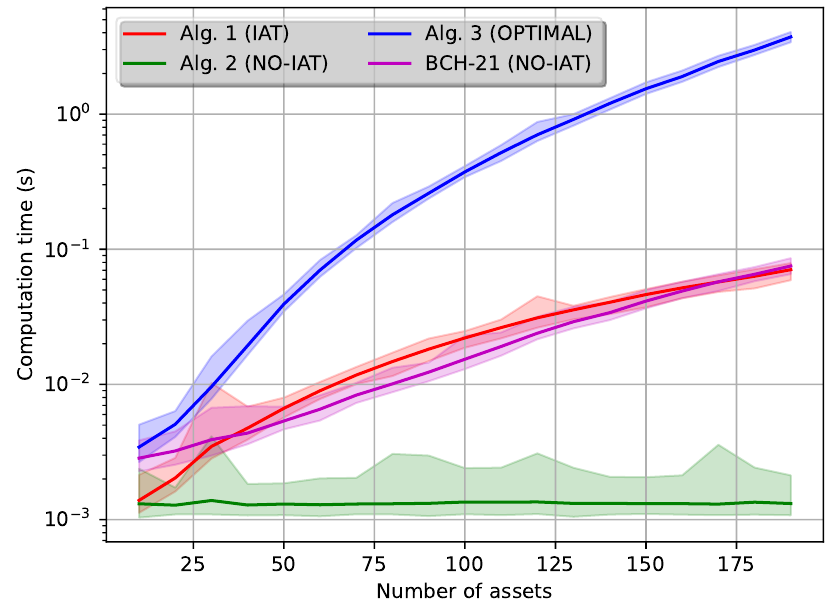
Figure 2. Computation time vs. number of assets for the fee minimization algorithms. The center lines represent averages on 1000 tests for each algorithm. The borders of the shaded areas represent the maximum and minimum values. The computation time in the y-axis is in logarithmic scale. NO-IAT stands for ‘without IAT’.